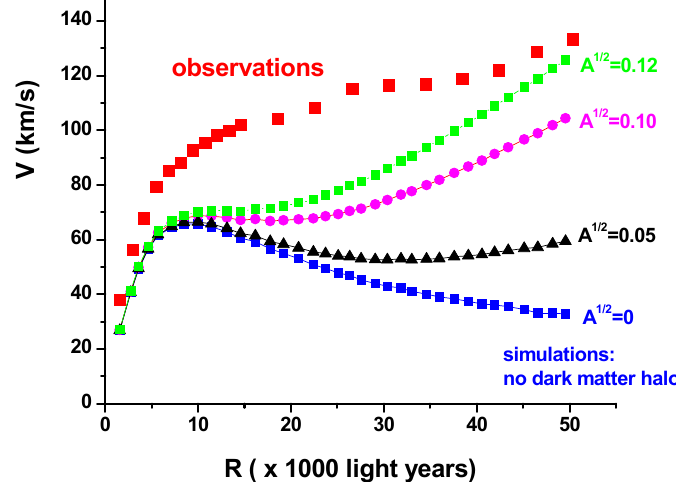
Figure 3. Numerical simulations of the rotation curve in M33, which were performed for di ff erent magnitudes of A 1 / 2 between 0 and 0.12 assuming a disk-shape mass distribution of the visible matter and no dark-matter halo. The di ff erent magnitudes of A 1 / 2 used in this figure and in Figures 1 and 2 are meant to give a plausible range of this constant. Calculations performed using A 1 / 2 = 0.10 and A 1 / 2 = 0.12 show a considerably improved agreement with the astronomical data (these results compared with Figure 1: the huge di ff erence between the observed and the calculated rotational velocities is almost eliminated).